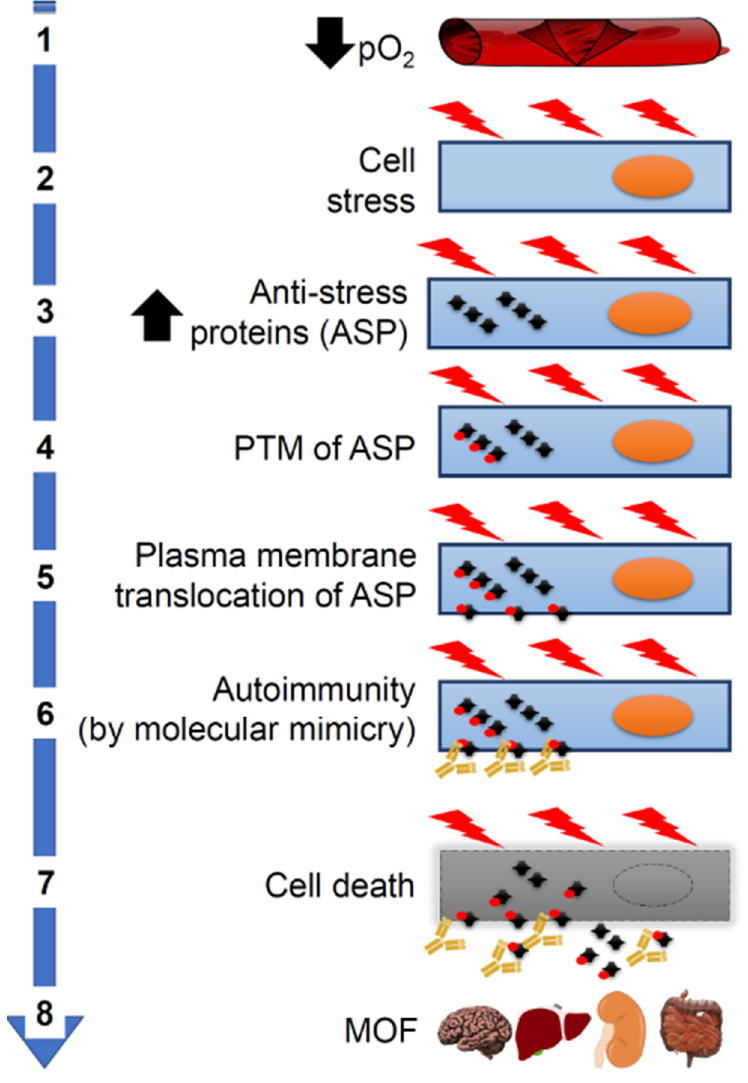
Figure 3. Pathogenesis of systemic complications of COVID-19. Molecular mimicry could be the cause of aggravation of COVID-19 patients through its participating in crucial steps of the pathogenetic cascade. ( 1 ) Severe pneumonia causes a decrease in partial oxygen pressure (pO ₂ ). ( 2 ) This in turn causes cellular stress and increased synthesis of proteins (including antistress proteins, ASP). ( 3 ) ASP accumulate in the cytosol. ( 4 ) ASP undergo post-translational modifications (PTM). ( 5 ) Modified ASP migrate to the plasma cell membrane. ( 6 ) ASP antigenic epitopes shared with SARS-CoV-2 proteins (molecular mimicry) become accessible on the outer surface of the cells to crossreactive antiviral antibodies, which act as autoantibodies and cause autoimmunity. ( 7 ) Autoimmunity mechanisms damage and kill the host’s cells. ( 8 ) This kind of cell death occurs in many organs causing multiorgan failure (MOF).